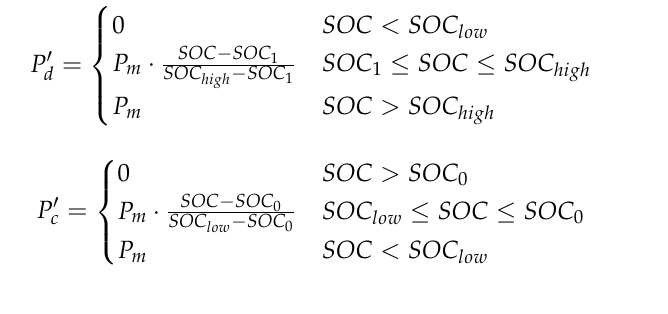
Figure 5. ( a ) Energy storage for SOC recovery power demand; ( b ) output power limit to prevent ACE from exceeding the limit.